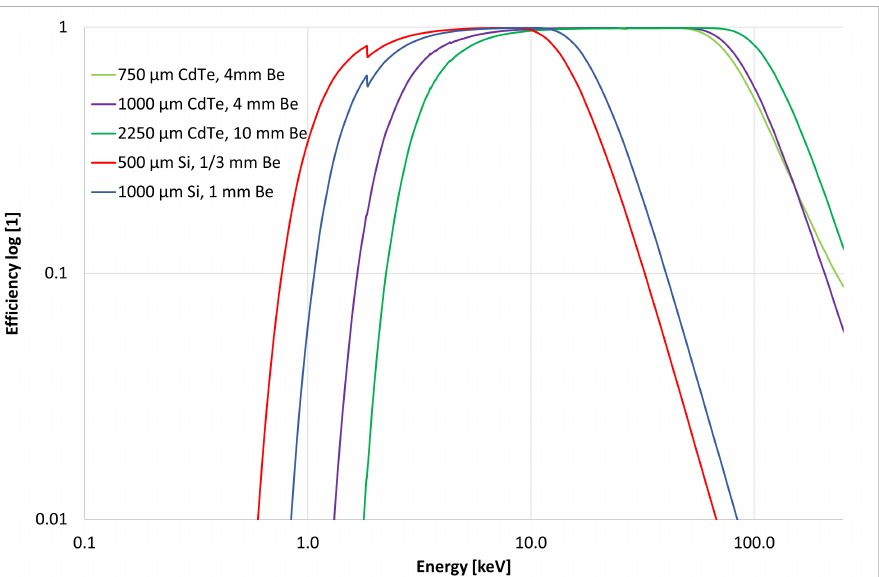
Figure 5. Detection efficiency of X rays and gamma rays according photon energy. Values shown for selected configurations of semiconductor sensor material and thickness (500 µ m Si, and 1000 and 2250 µ m CdTe). Data computed using NIST attenutation values (physics.nist.gov, accessed on 28 February 2022) and nominal device specifications. For more information, visit www.amptek.com. Adapted from